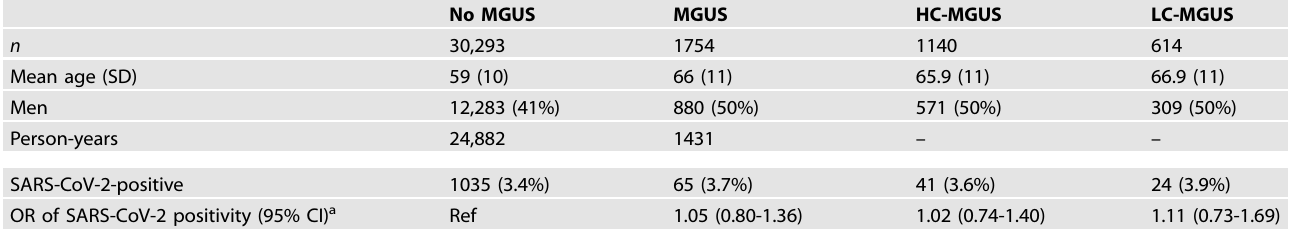
Table 1. Baseline characteristics of study participants tested for SARS-CoV-2 and the association between MGUS and SARS-CoV-2